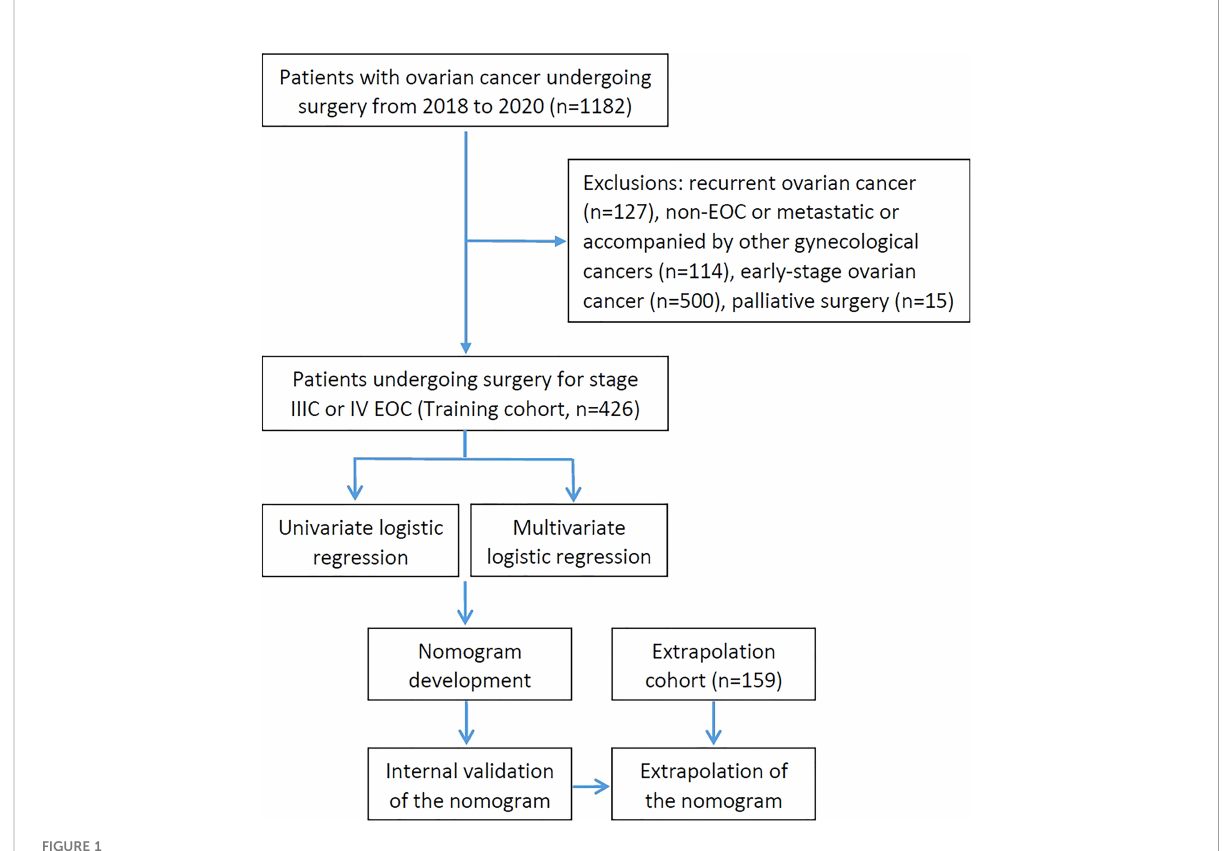
FIGURE 1 Flow chart of the overall